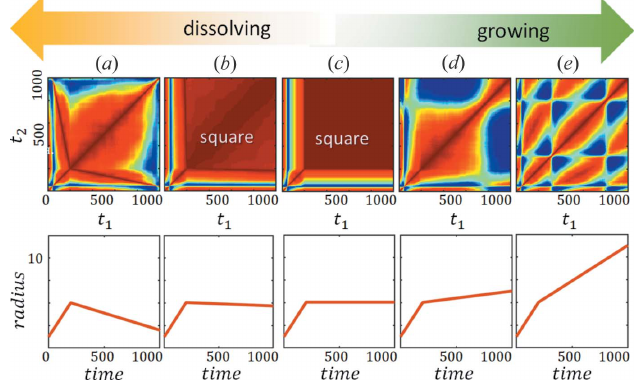
Figure 6 TTCs of the early stage of LLPS: for ( a ) experiment, ( b ) CH equation- based simulation and ( c ) the RE approach. ( a ) and ( b ) are initial parts of TTCs in Figs. 2( a ) and 2( b ), correspondingly, and ( c ) demonstrates the TTC of the particle-based simulation with the significant decrease in the rate of the Brownian motion with time and simultaneous growth of the particles (Fig. S9).